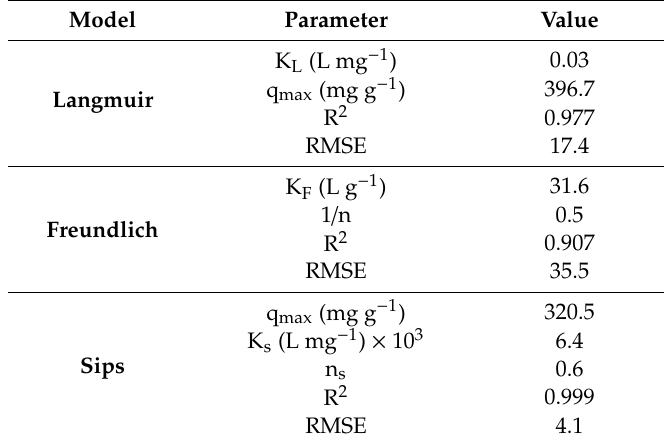
Table 3. Comparison of several MB adsorption capacities reported in the literature.